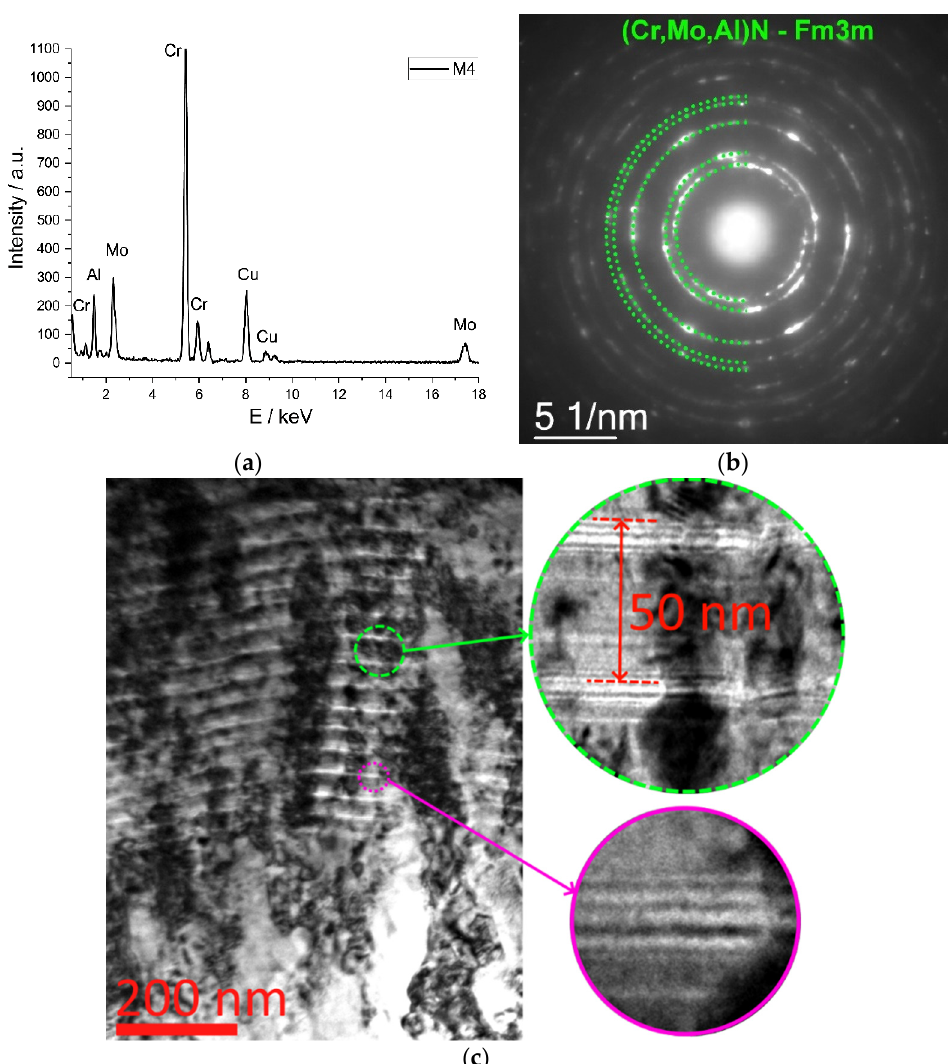
Figure 1. ( a ) Diffraction patterns, ( b ) selected area electron diffraction (SAED) pattern, ( c ) micro- and nanostructure of the Cr,Mo-(Cr,Mo)N-(Cr,Mo,Al)N coating.